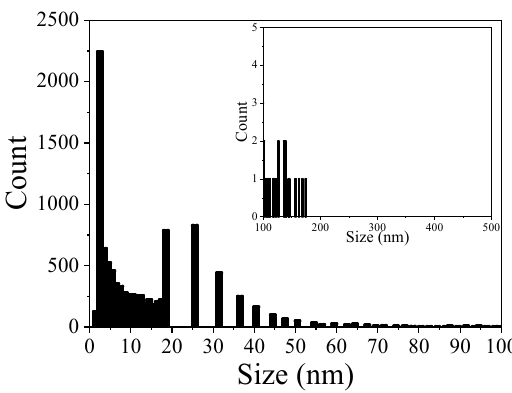
Figure 9. Histogram of the disk size distribution of GP.